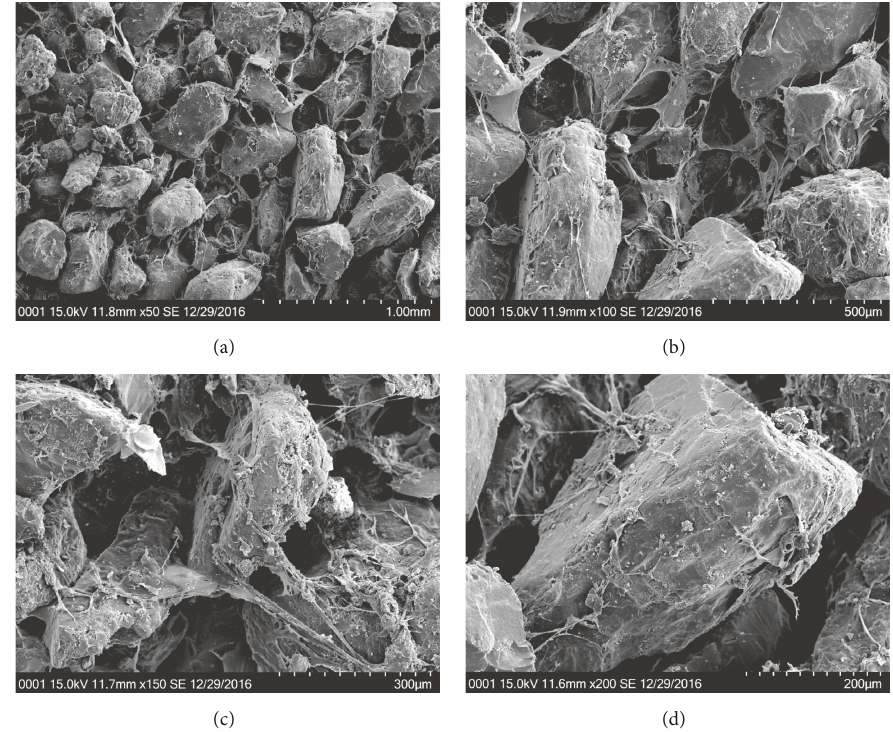
Figure 16: SEM images of specimen reinforced with PSS 5%: (a) 50 times magnification, (b) 100 times magnification, (c) 150 times magnification, and (d) 200 times